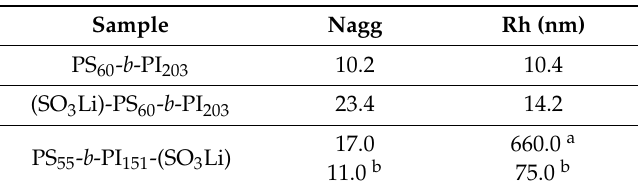
Table 2. Micellar characteristics for the PS- b -PI diblock copolymers in n -decane at 25 ◦ C as determined by Sotiriou et al.